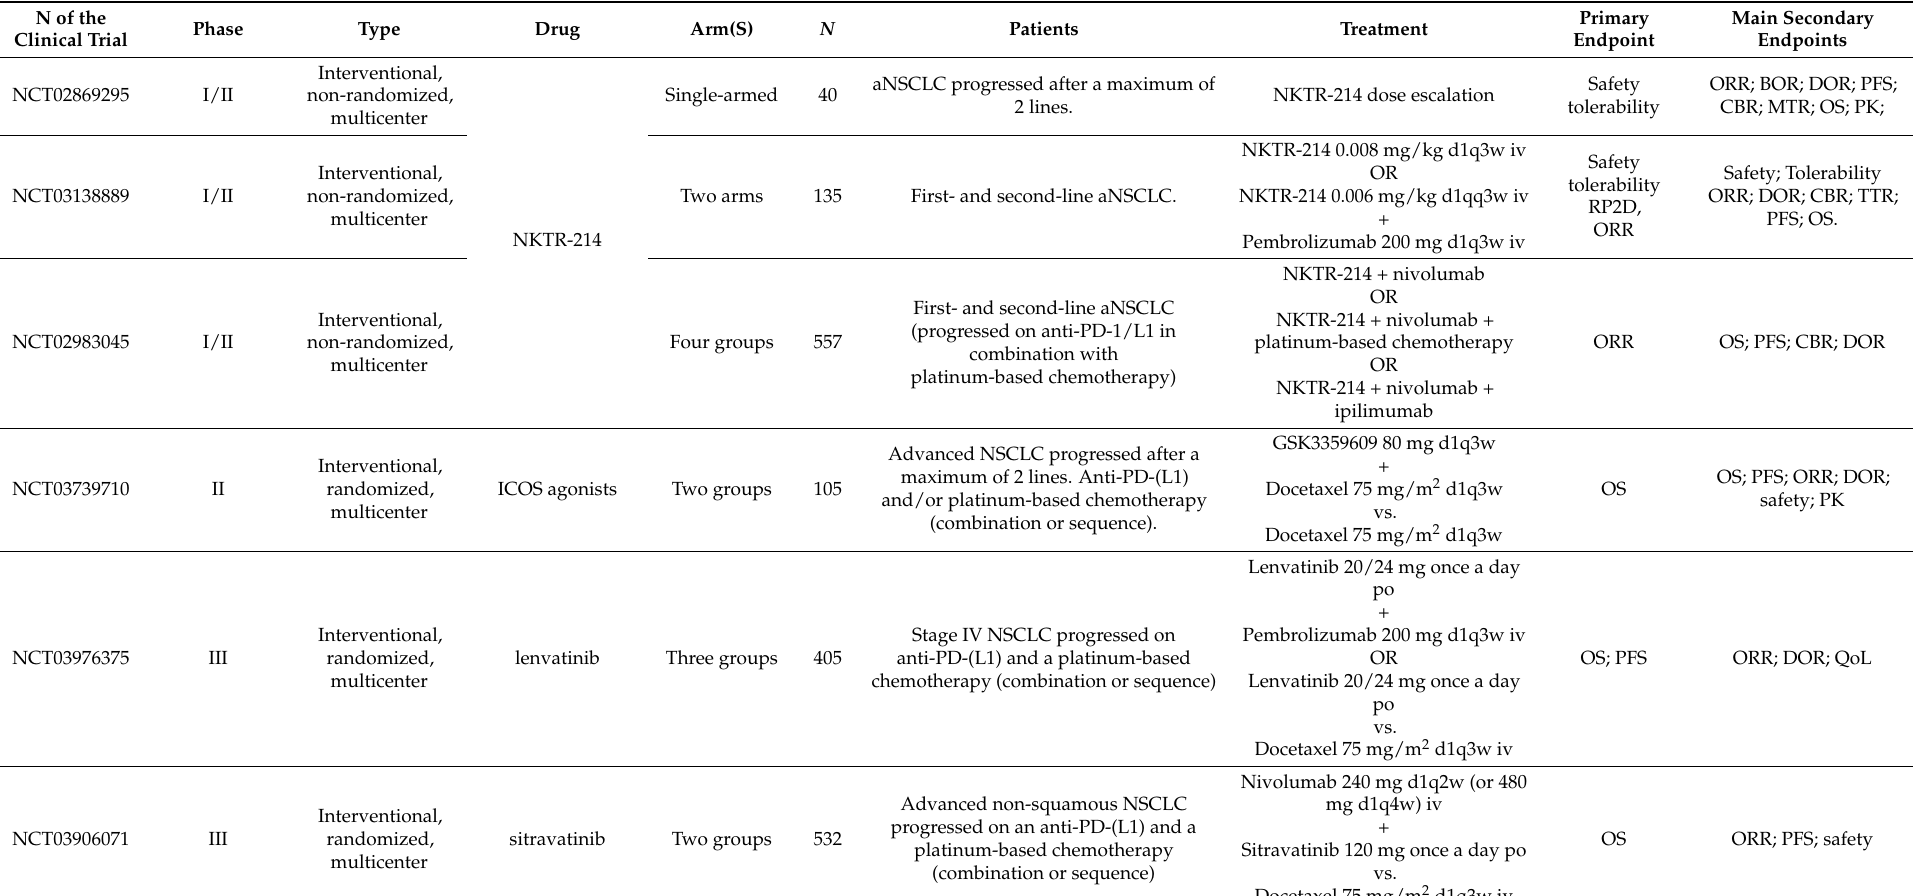
Table 4. Most relevant ongoing trials investigating different treatment strategies in NSCLC beyond first-line